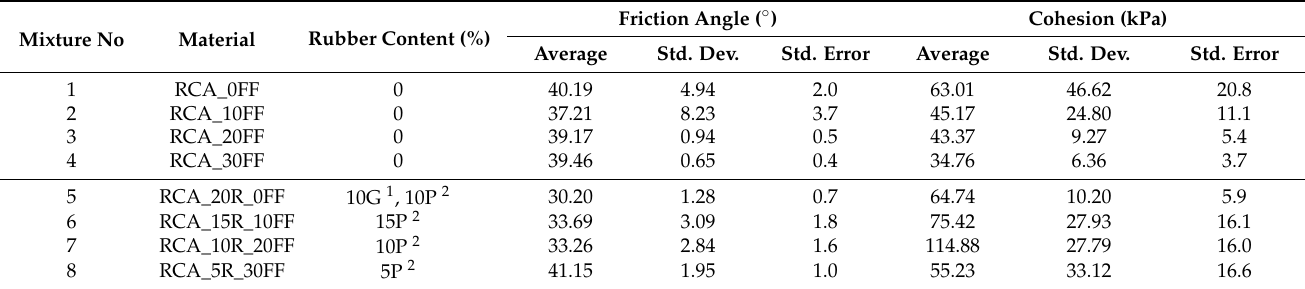
Table 7. Results of strength parameters and basic statistics for studied